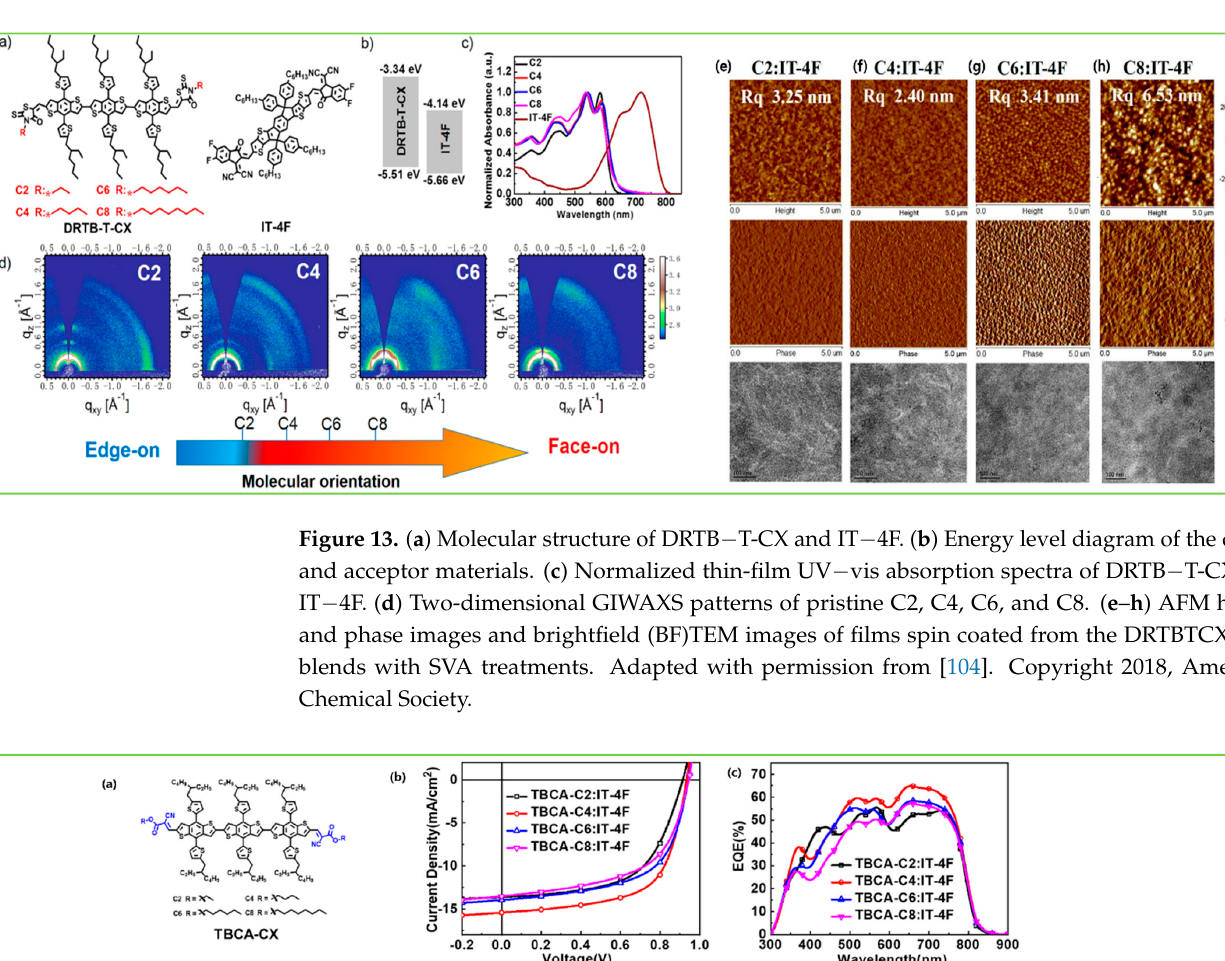
Figure 12. ( a , b ) AFM height images of C − F:N3 and C − 2F:N3 blend films. ( c , d ) GIWAXS two-dimen- sional diffraction patterns of C − F:N3 and C-2F:N3. ( e , f ) In-plane and out-of-plane line-cut profiles of the two-dimensional GIWAXS data of C-F:N3 and C − 2F:N3 blend films. ( g ) Chemical structures of C − F and C − 2F. ( h , i ) TEM images of C − F: N3 and C − 2F: N3 blend films, respectively. Adapted with permission from [49]. Copyright 2022, American Chemical Society.